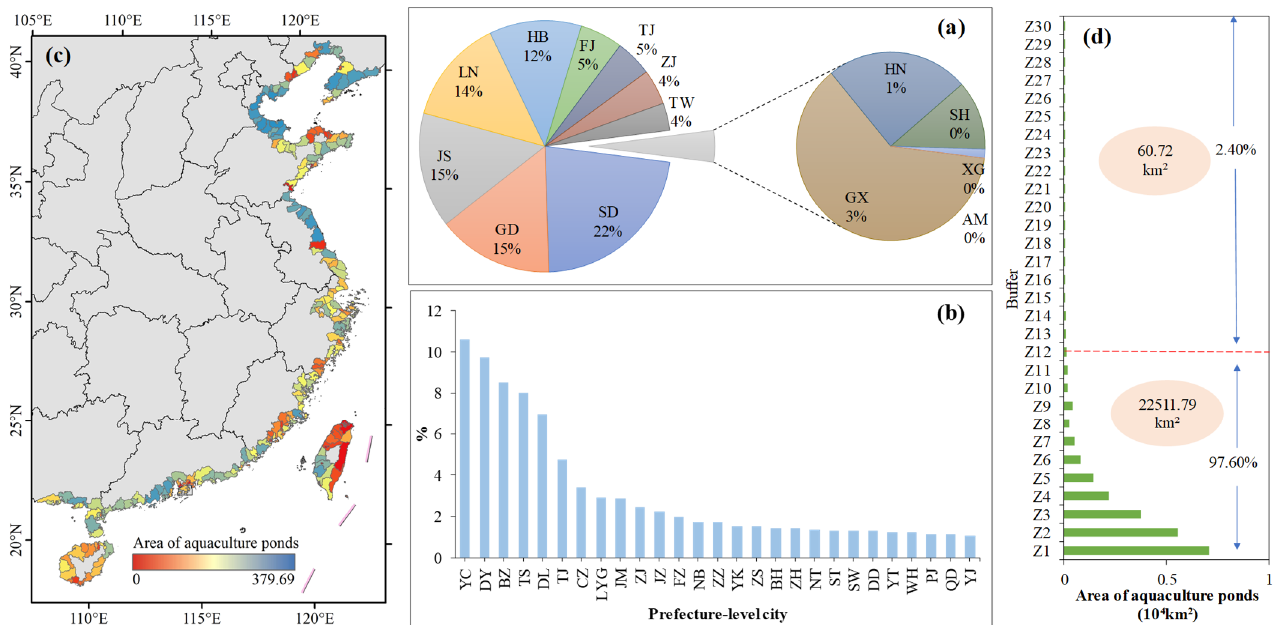
Figure 6. Area distribution of aquaculture ponds along the coast of China. ( a ) The area distribution of aquaculture ponds in each province; ( b ) the distribution of the top 27 prefecture-level cities in terms of aquaculture pond area; ( c ) aquaculture pond area at the city level; ( d ) west coast of Taiwan Province as an example of the number of aquaculture pond areas in 30 buffer zones.